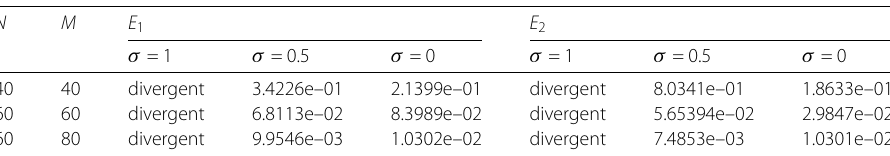
Table 2 Comparison of E 1 and E 2 , the maximum absolute errors, for different values of N , M in Example 1, when 0 < t ≤ 5